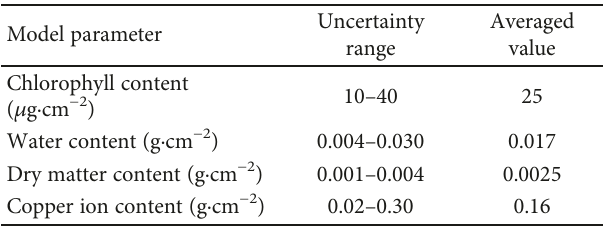
Table 1: Uncertainty range and expectations of the model